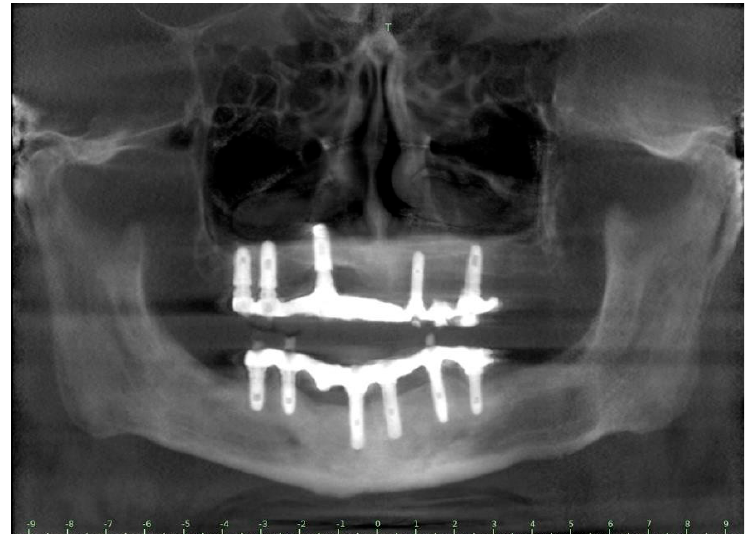
Figure 8. CBCT Panorex projection of the clinical case at the follow up.